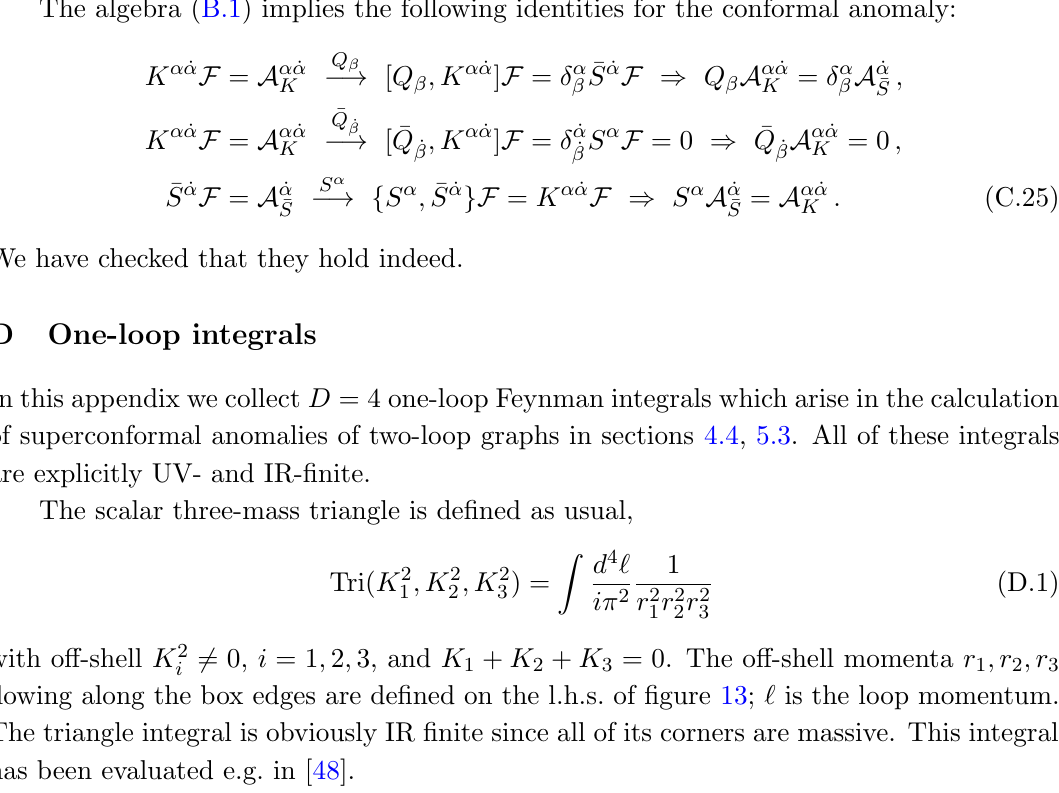
Figure 13 . Left: three-mass scalar triangle with K 2 ~ Kr with numerator [1 3 ~ r 2 j 2 i de(cid:12)ned in eq. (D.2). Legs k 1 ; k 2 ; k 3 are massless, i.e. k i = j i i [ i j , and j K = k 1 k 2 k 3 is (cid:0) (cid:0) (cid:0)